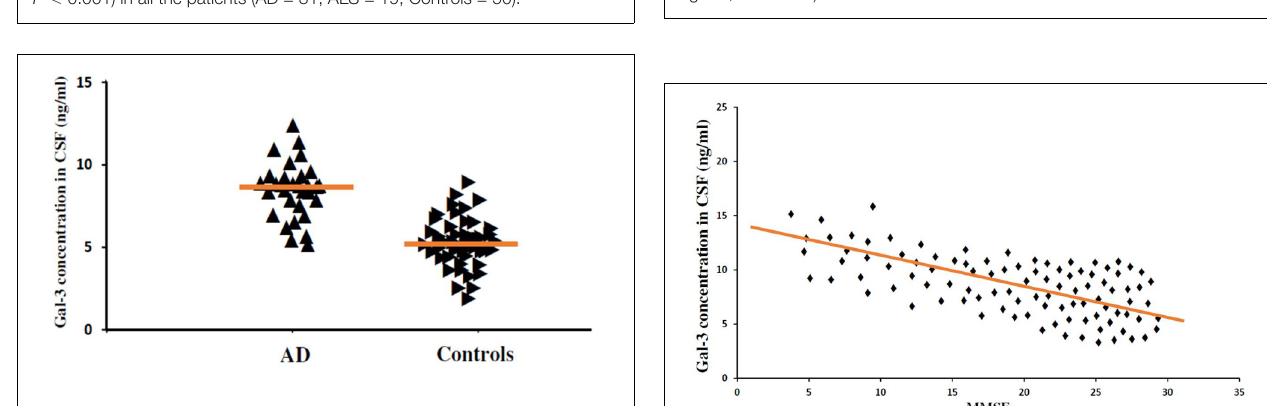
FIGURE 6 | The concentrations of Gal-3 in CSF (ng/mL) of AD patients and healthy controls. AD patients showed enhanced Gal-3 concentrations in CSF as compared to the healthy controls (AD vs. healthy controls [mean ± SD] 8.37 ± 2.79 vs. 5.19 ± 2.23 ng/mL; P = 0.019).